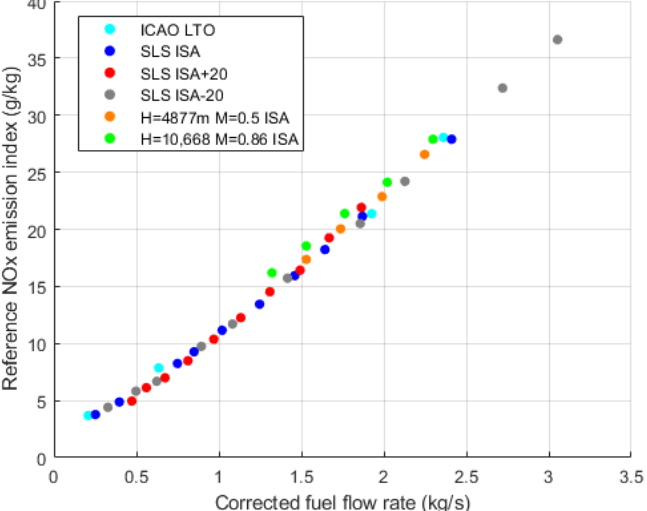
Figure 3. Relationship between CF6 engine corrected fuel flow rate and reference NOx emission index [26].